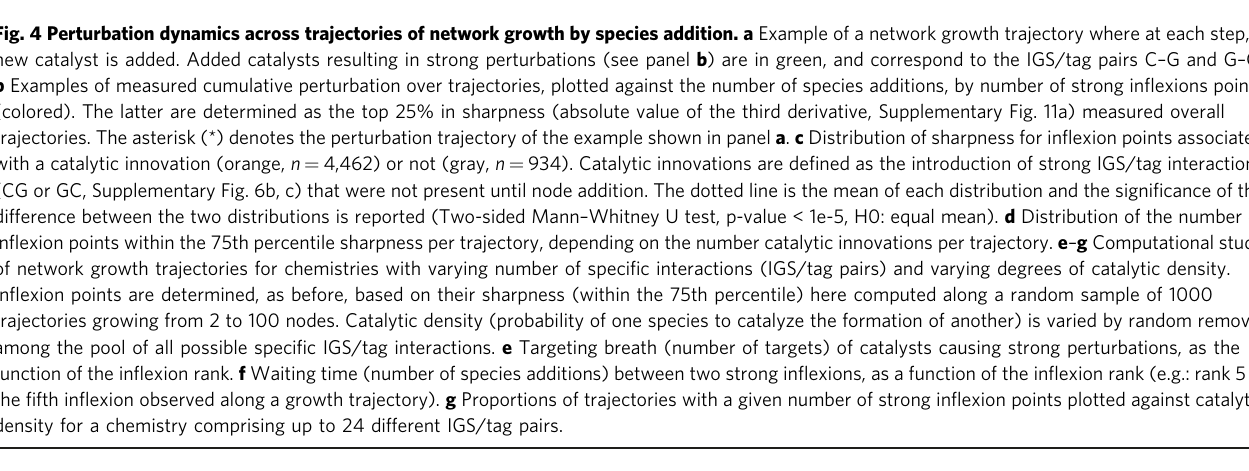
Fig. 4 Perturbation dynamics across trajectories of network growth by species addition. a Example of a network growth trajectory where at each step, a new catalyst is added. Added catalysts resulting in strong perturbations (see panel b ) are in green, and correspond to the IGS/tag pairs C – G and G – C. b Examples of measured cumulative perturbation over trajectories, plotted against the number of species additions, by number of strong in fl exions points (colored). The latter are determined as the top 25% in sharpness (absolute value of the third derivative, Supplementary Fig. 11a) measured overall trajectories. The asterisk (*) denotes the perturbation trajectory of the example shown in panel a . c Distribution of sharpness for in fl exion points associated with a catalytic innovation (orange, n = 4,462) or not (gray, n = 934). Catalytic innovations are de fi ned as the introduction of strong IGS/tag interactions (CG or GC, Supplementary Fig. 6b, c) that were not present until node addition. The dotted line is the mean of each distribution and the signi fi cance of the difference between the two distributions is reported (Two-sided Mann – Whitney U test, p-value < 1e-5, H0: equal mean). d Distribution of the number of in fl exion points within the 75th percentile sharpness per trajectory, depending on the number catalytic innovations per trajectory. e – g Computational study of network growth trajectories for chemistries with varying number of speci fi c interactions (IGS/tag pairs) and varying degrees of catalytic density. In fl exion points are determined, as before, based on their sharpness (within the 75th percentile) here computed along a random sample of 1000 trajectories growing from 2 to 100 nodes. Catalytic density (probability of one species to catalyze the formation of another) is varied by random removal among the pool of all possible speci fi c IGS/tag interactions. e Targeting breath (number of targets) of catalysts causing strong perturbations, as the function of the in fl exion rank. f Waiting time (number of species additions) between two strong in fl exions, as a function of the in fl exion rank (e.g.: rank 5 is the fi fth in fl exion observed along a growth trajectory). g Proportions of trajectories with a given number of strong in fl exion points plotted against catalytic density for a chemistry comprising up to 24 different